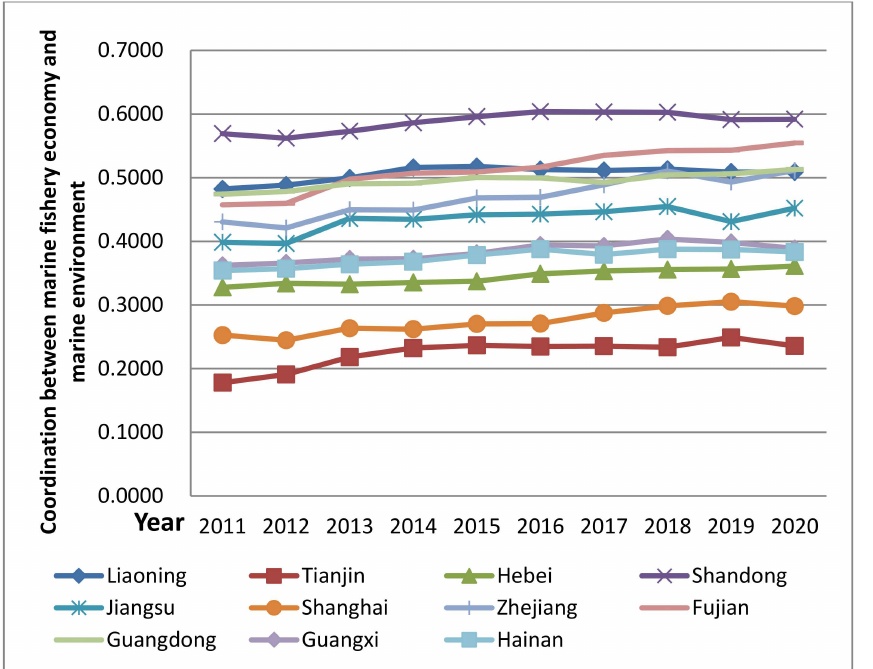
Figure 3. Coordination between the marine-environment quality and marine-fishery-economy